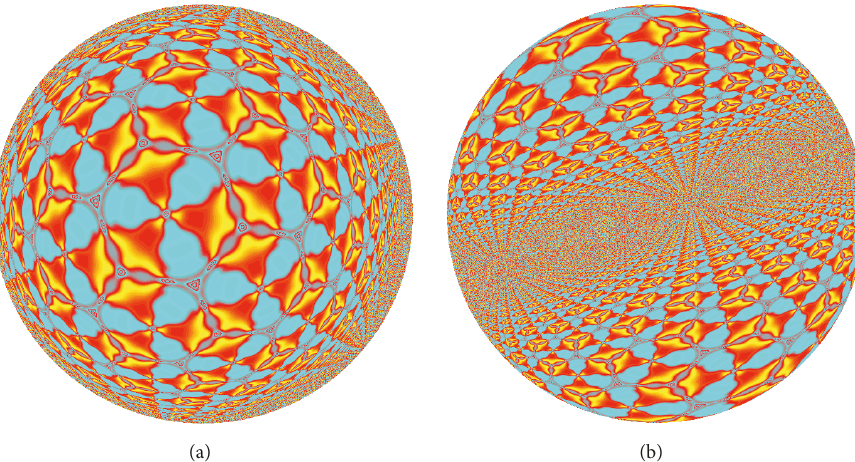
Figure 7: Two spherical wallpaper patterns with the 𝑝3𝑚 symmetry. The camera view of (a) is perpendicular to plane 𝑋𝑂𝑌 and passed the origin, while (b) aims at